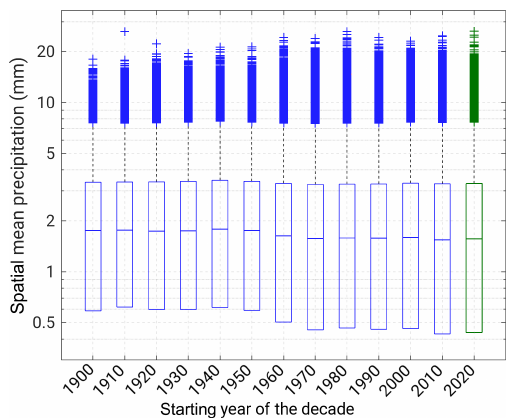
Figure 6. Boxplot of the distribution of daily spatial mean precipi- tation values (including dry days) for ME. Each decade was consid- ered separately. The centerline of a box marks the median; the lower and upper ends of the box mark the 25th and 75th percentiles (in- terquartile range); the whiskers represent approximately the 99.9th percentile; the prediction part is marked in green.